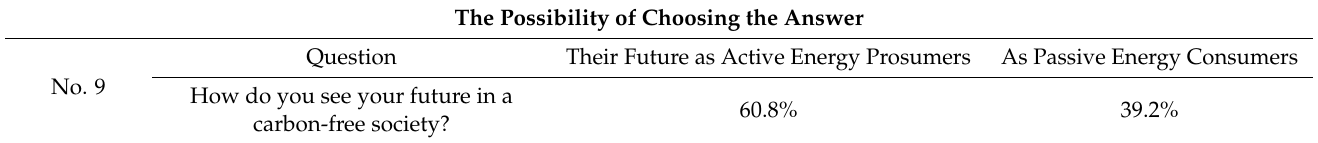
Table 10. Question no. 10, research results.